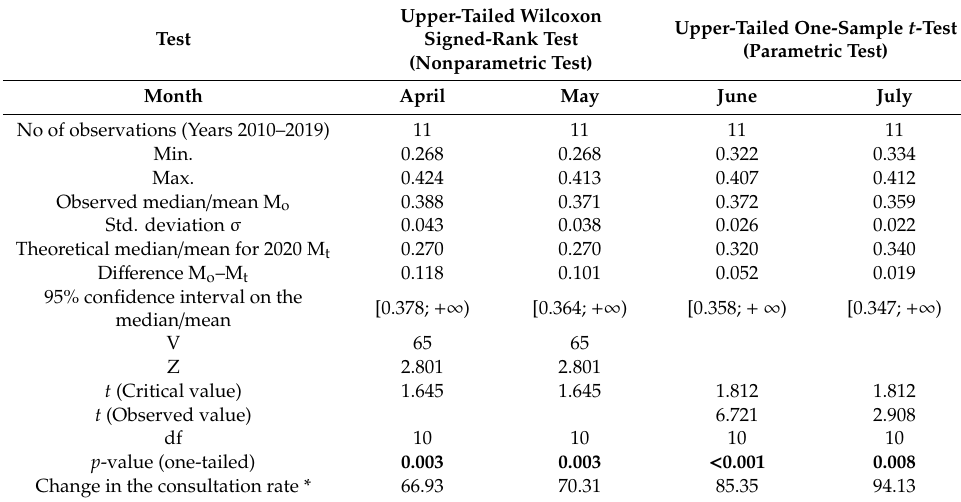
Table1. Resultsoftheupper-tailedWilcoxonsigned-ranktestappliedtononparametricdatadistribution for April and May and one-sample t -test for parametric distribution for June and July (upper-tailed tests; p <